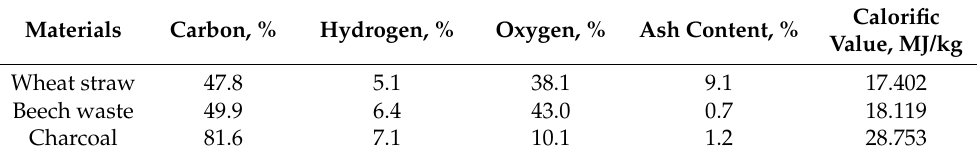
y = 0.3362x + 1.3184